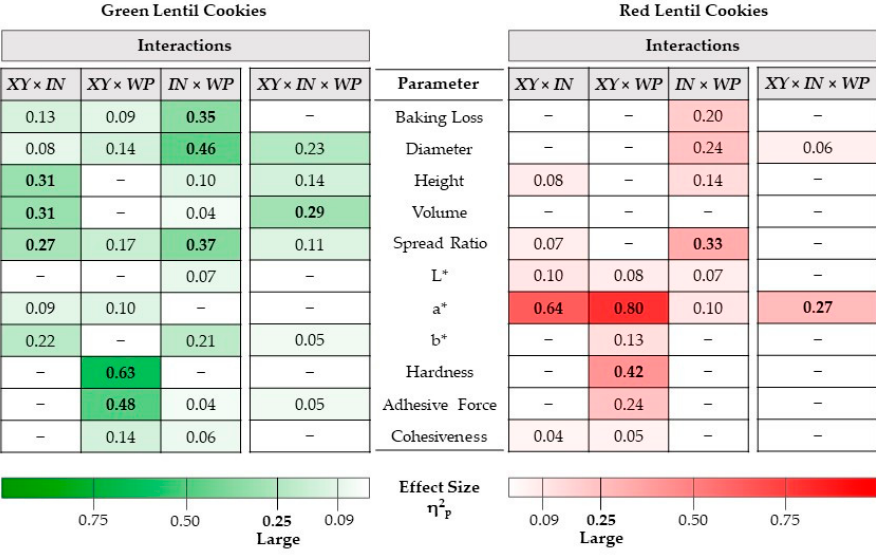
Figure 1. Results of factorial ANOVA analysis performed on lentil cookies’ data. The partial eta- squared ( η 2 p ) of the interactions is shown only for significant values ( p < 0.05). Mark ‘ − ’ means that the interaction effect was not significant (p > 0.05). XY: xylitol, IN: inulin, WP: whey protein isolate.